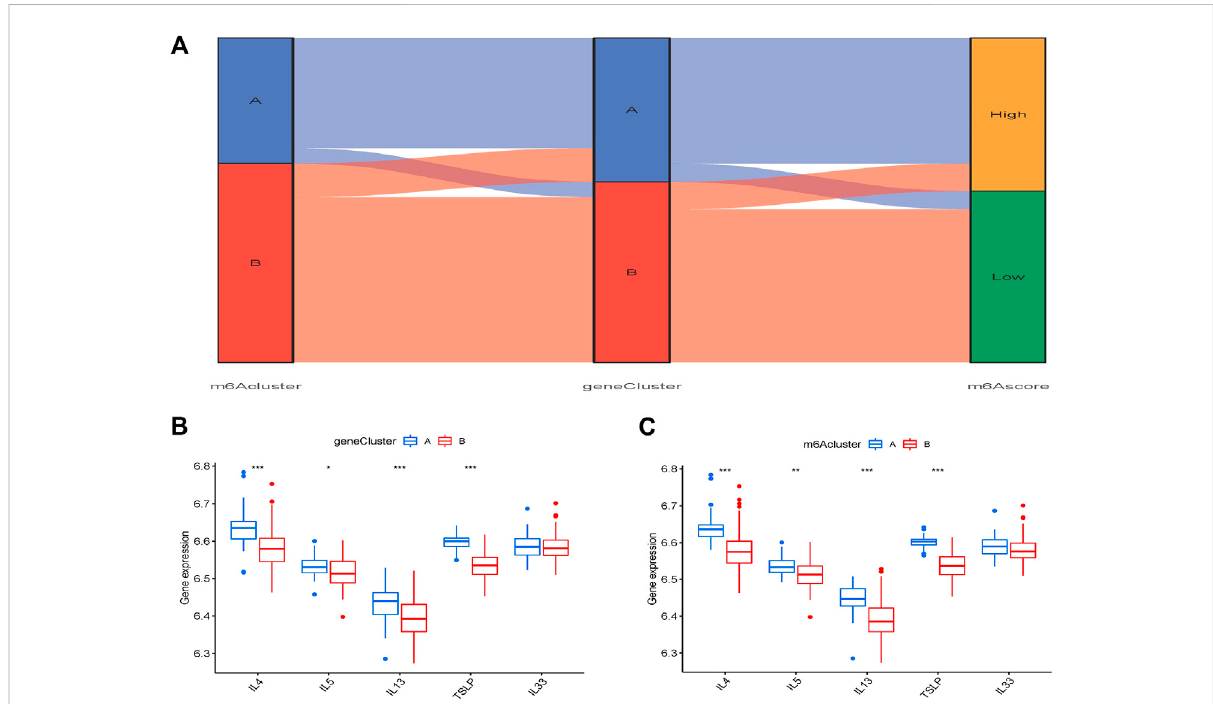
FIGURE 9 In fl uence of m 6 A pattern in OA. (A) A Sanchi plot illustrating the link between m 6 A pattern, m 6 A gene pattern, and m 6 A score. (B) Different transcriptional activity of thymic stromal IL-4, IL-5, IL-13, lymphopoietin (TSLP), and interleukin (IL)-33 clusters A and B. (C) Different transcriptional activity of IL-4, IL-5, IL-13, TSLP, and IL-33 between gene clusters A and B. * p < 0.05, ** p < 0.01, and *** p <